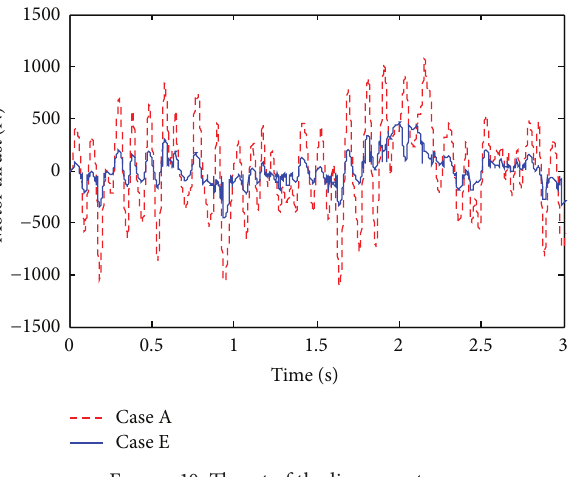
Figure 10: Thrust of the linear motor.